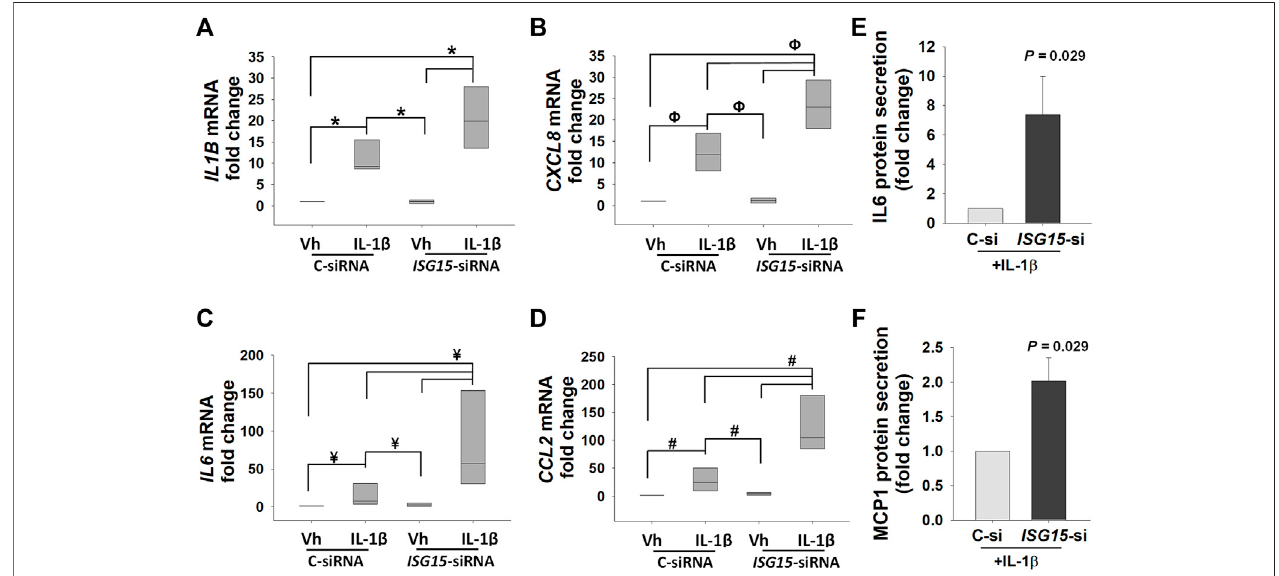
FIGURE 7 | ISG15 silencing ampli fi es IL-1 β induced expression of pro-in fl ammatory cytokines. (A – D) Expression levels of IL1B , CXCL8 , IL6 , and CCL2 mRNA in control vs. ISG15 -siRNA transfected HTR8/SVneo cells, followed by 6 h treatment with vehicle (vh) or 10 ng/ml IL1 β (IL-1 β ). (E,F) IL-6 and MCP-1, aka CCL2 , protein secretion levels in ISG15 -siRNA vs. control transfected HTR8/SVneo cells treated with 10 ng/ml IL1 β (IL-1 β ). (A – D) : Bars represent median values and compared by using One way ANOVA, n = 4, * p = 0.007, Φ P = 0.005, ¥ p = 0.008, # p = 0.003. (E,F) : Bars represent Mean ± SEM and compared by using t -test ( n = 4).